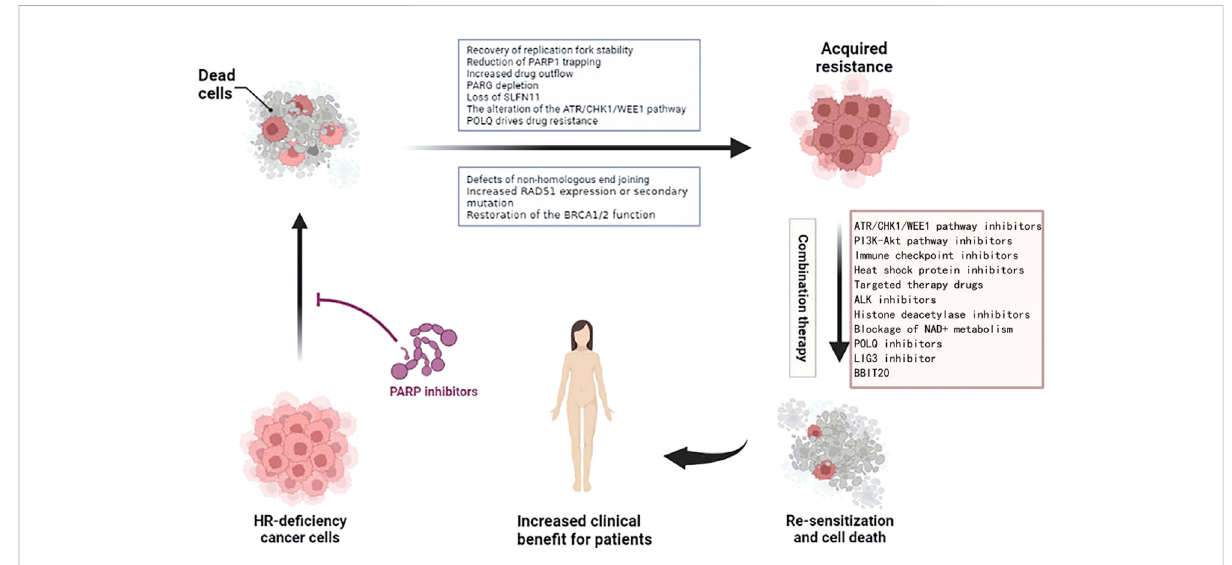
FIGURE 5 Combination treatment options for ovarian cancer resistant to PARPi. Figures have been created with